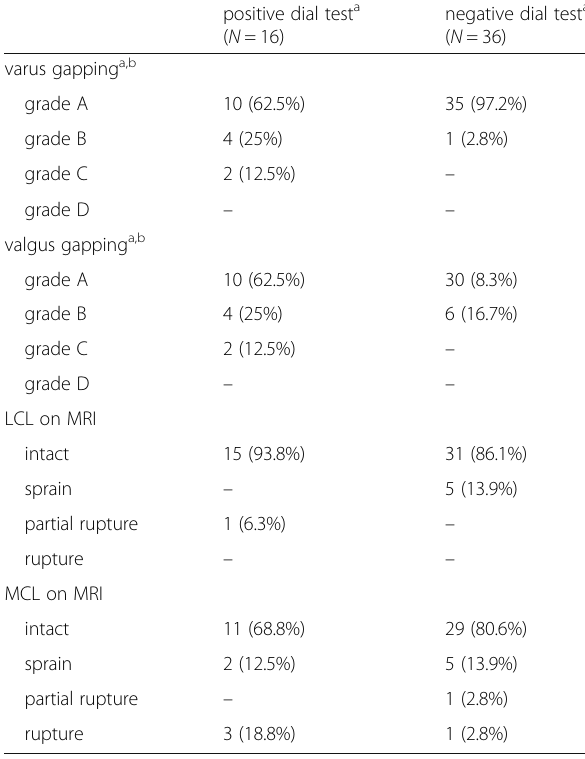
Table 3 Physical examination and MRI features indicating collateral injury in 52 patients with ACL injury with a positive and negative dial